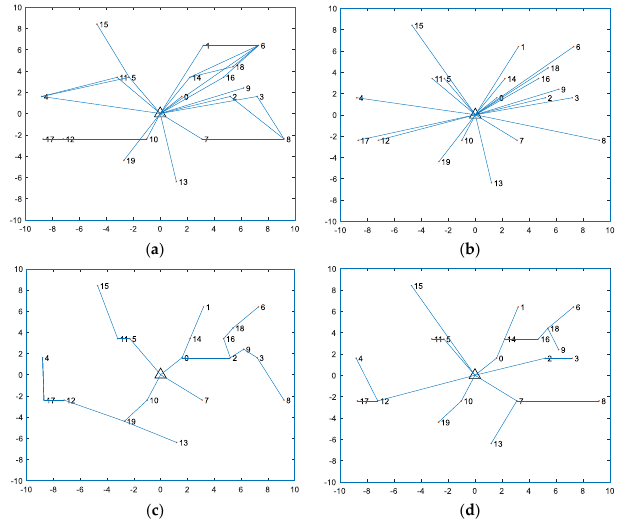
Figure 4. Transmission routing results for the 20-node WPCN. ( a ) Transmission routing result obtained by the proposed method; ( b ) Transmission routing result obtained by the “ without user cooperation ” method; ( c ) Transmission routing result obtained by the “ GR ” method; ( d ) Transmission routing result obtained by the “ RA ” method.